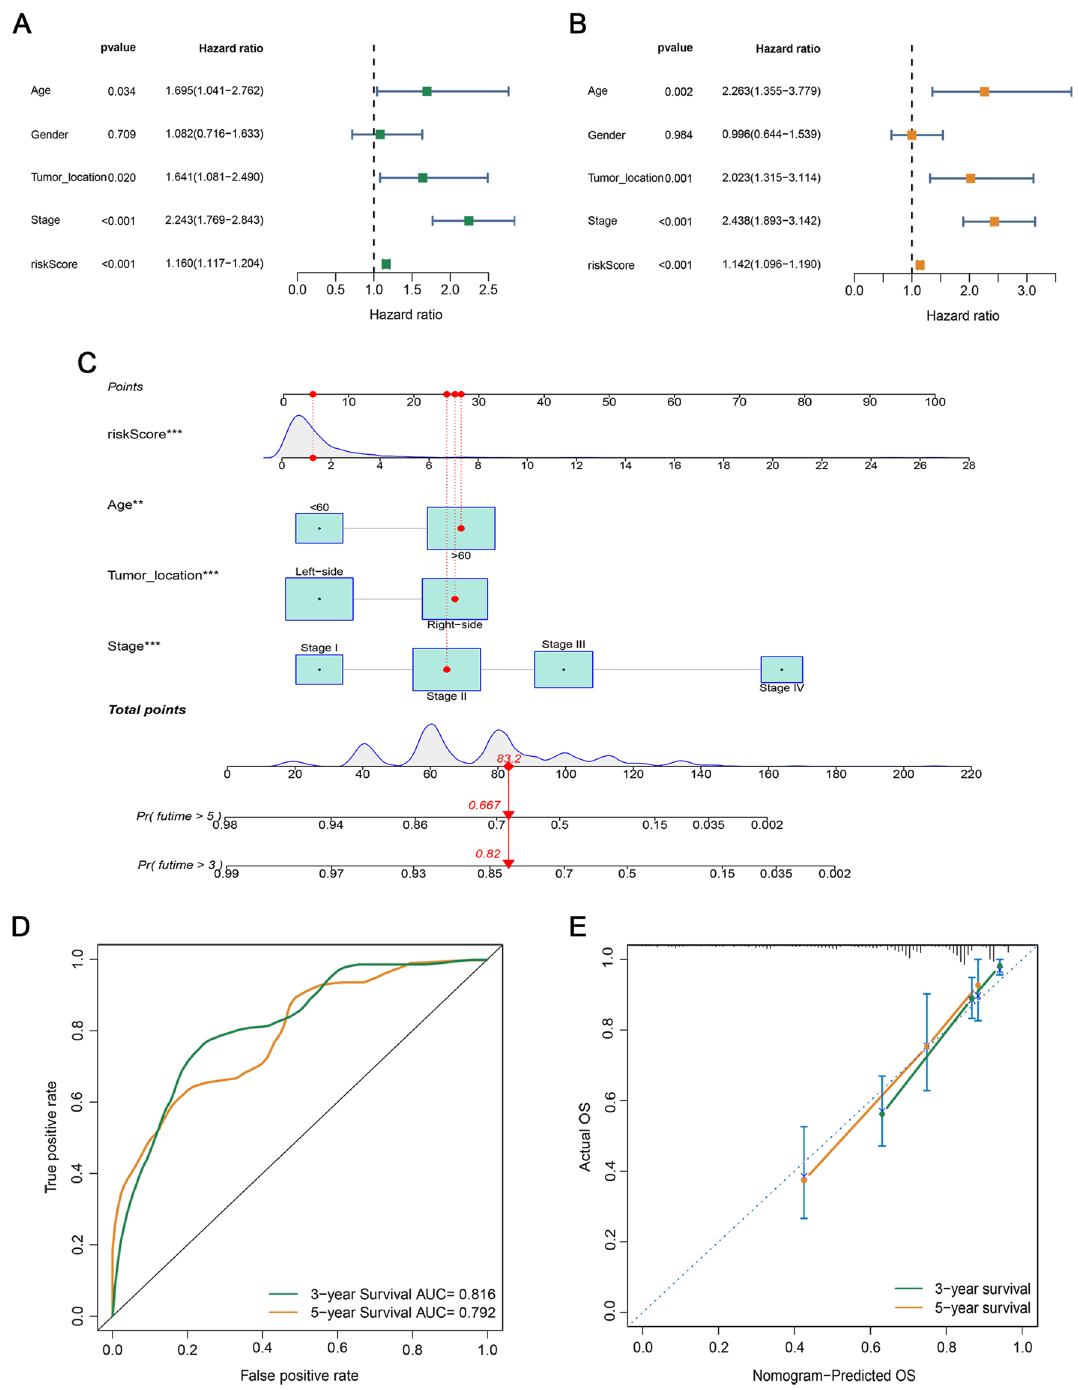
Figure 5. Establishment and evaluation of a predictive nomogram. ( A , B ) The forest map of the univariate and multivariate Cox regression analyses was carried out by the risk score combined with clinicopathological factors. ( C ) A nomogram was constructed based on the risk score and clinical factors. ( D ) ROC curves of the nomogram. ( E ) The calibration curves between the prediction by nomogram and actual